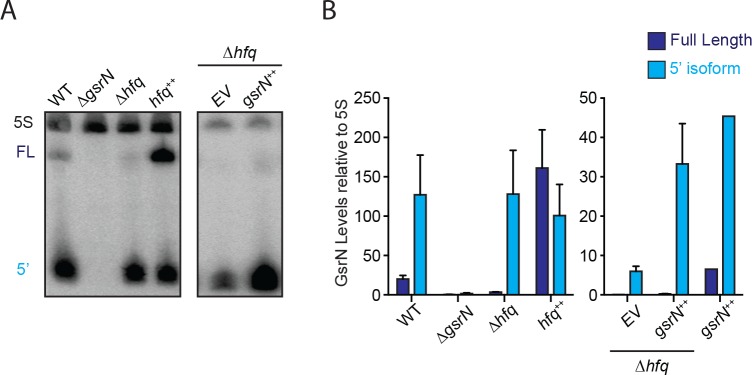
Hfq stabilizes full-length GsrN.(A) Northern blots of total RNA from wild type, ΔgsrN, Δhfq, hfq++, and Δhfq + gsrN ++ cultures (OD660 ≈ 0.2, since Δhfq and hfq++ have growth defects and cannot be grown to high densities [Irnov et al., 2017]). Blots were probed simultaneously with 32P-labeled oligonucleotides complementary to the 5’ end of GsrN and to 5S rRNA as a loading control. (B) Blots were quantified by densitometry. GsrN signal from the full-length (FL; dark blue) and 5’ isoform (5’; cyan) are normalized to 5S rRNA in each lane and multiplied by 100. Bars represent mean ±SD of triplicate extractions, each representing biologically independent samples.